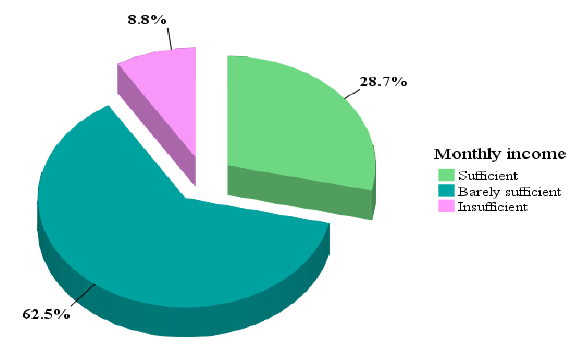
Figure 1. Distribution of RTA Victims According to Monthly Income (Source: Sulaimaniyah Main Emergency Hospital, Jan - June 2014).